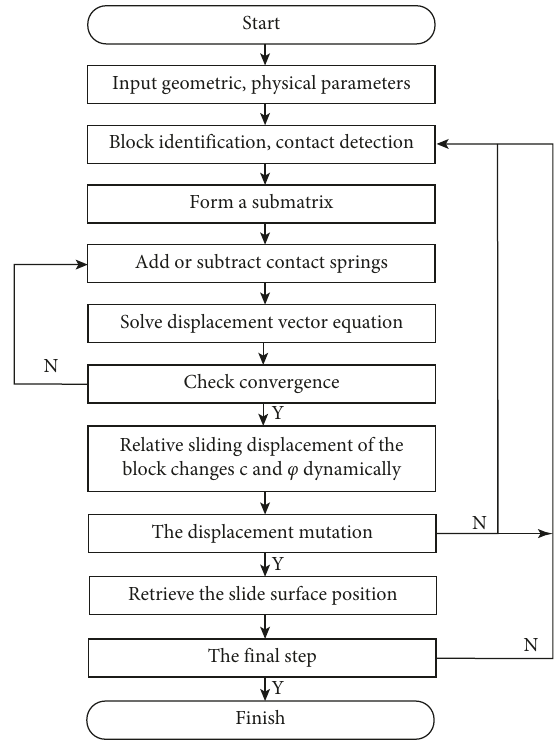
Figure 3: Flow chart of the DDA